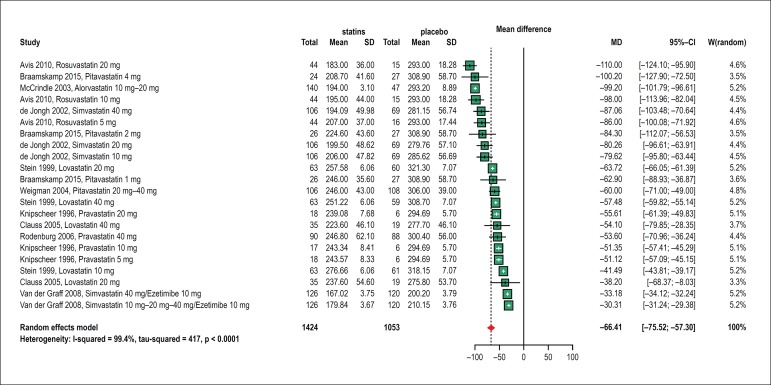
Forest plots showing the effect of statin therapy on total
cholesterol (TC) levels.